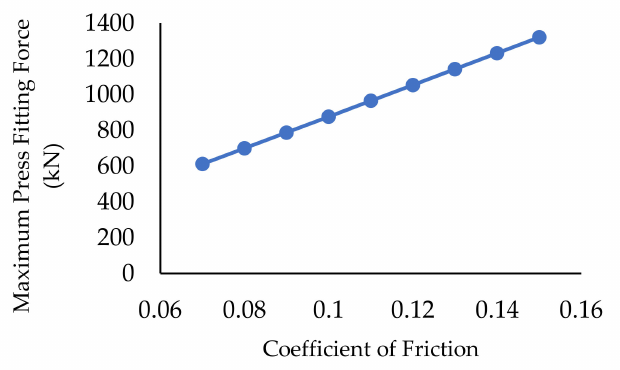
Figure 13. Maximum press-fitting force vs coefficient of friction.